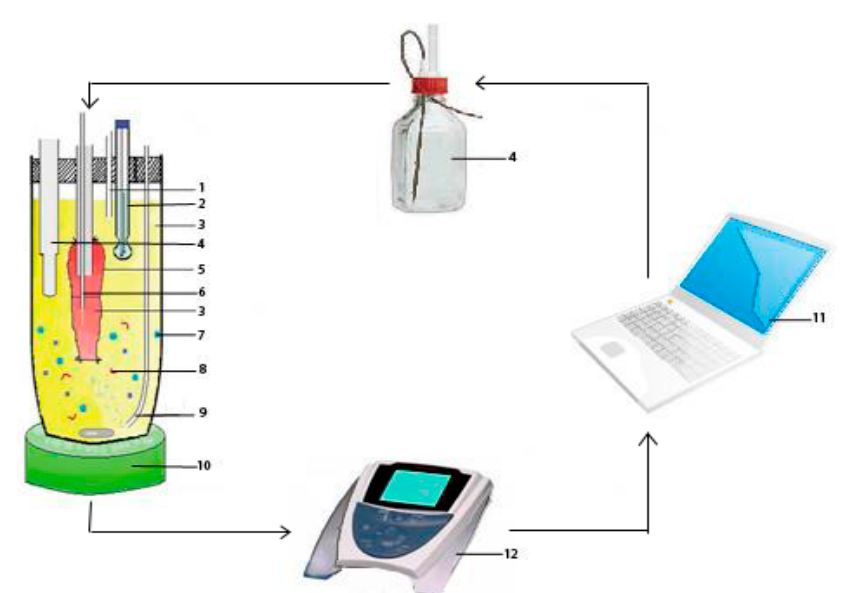
Figure 1. The new lipolysis-absorption model for lipid-based formulations: ( 1 ) Vent; ( 2 ) pH electrode; ( 3 ) intestinal tissue medium; ( 4 ) NaOH autoburette; ( 5 ) intestinal segment; ( 6 ) sampler; ( 7 ) a lipid-based formulation; ( 8 ) pancreatic lipase/colipase; ( 9 ) O 2 /CO 2 ; ( 10 ) temperature controlled stirrer; ( 11 ) computer; and ( 12 ) pH-stat meter controller.